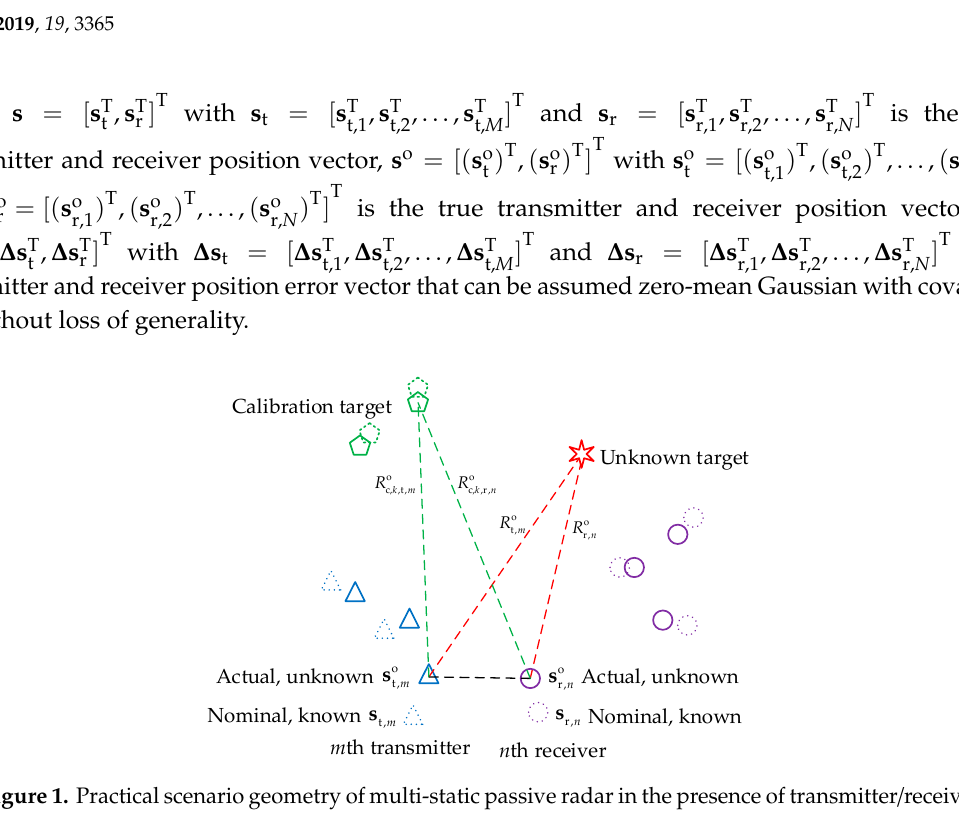
Figure 1. Practical scenario geometry of multi-static passive radar in the presence of transmitter/receiver position error and calibration targets.